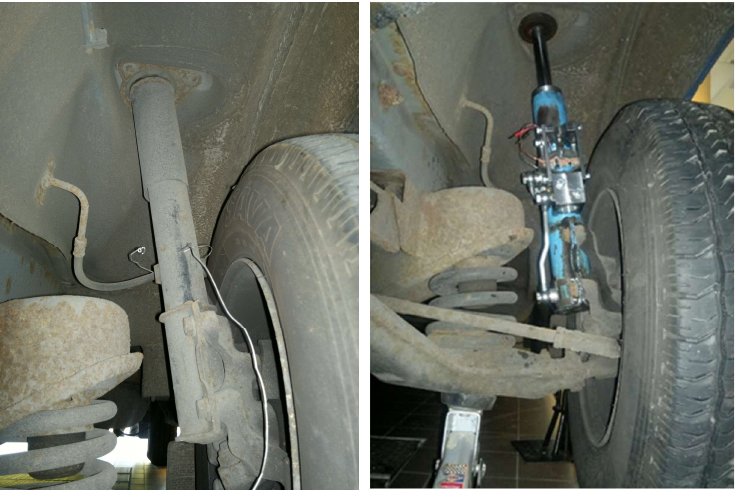
Figure 18. On the left factory damper and on the right PZD-FT damper built into the suspension of a commercial van vehicle.